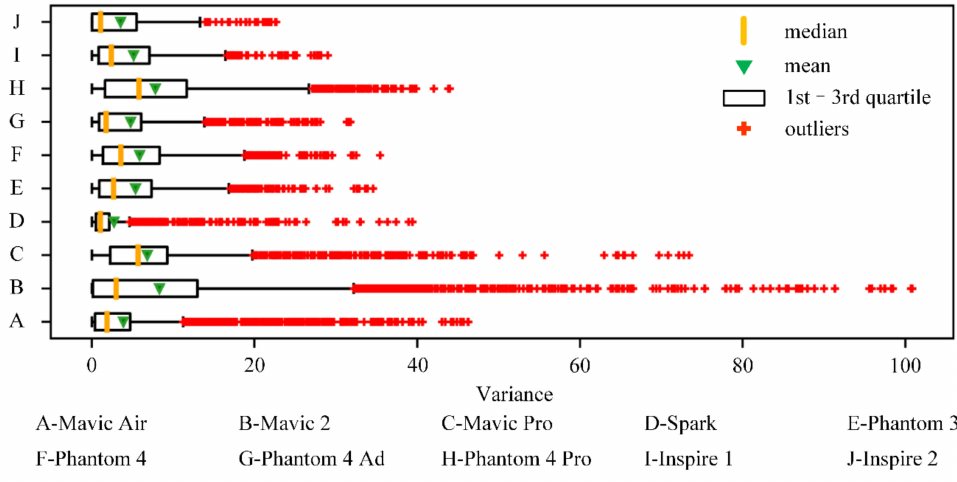
Figure 4. Distribution of the change of GS for each type of quadrotor.